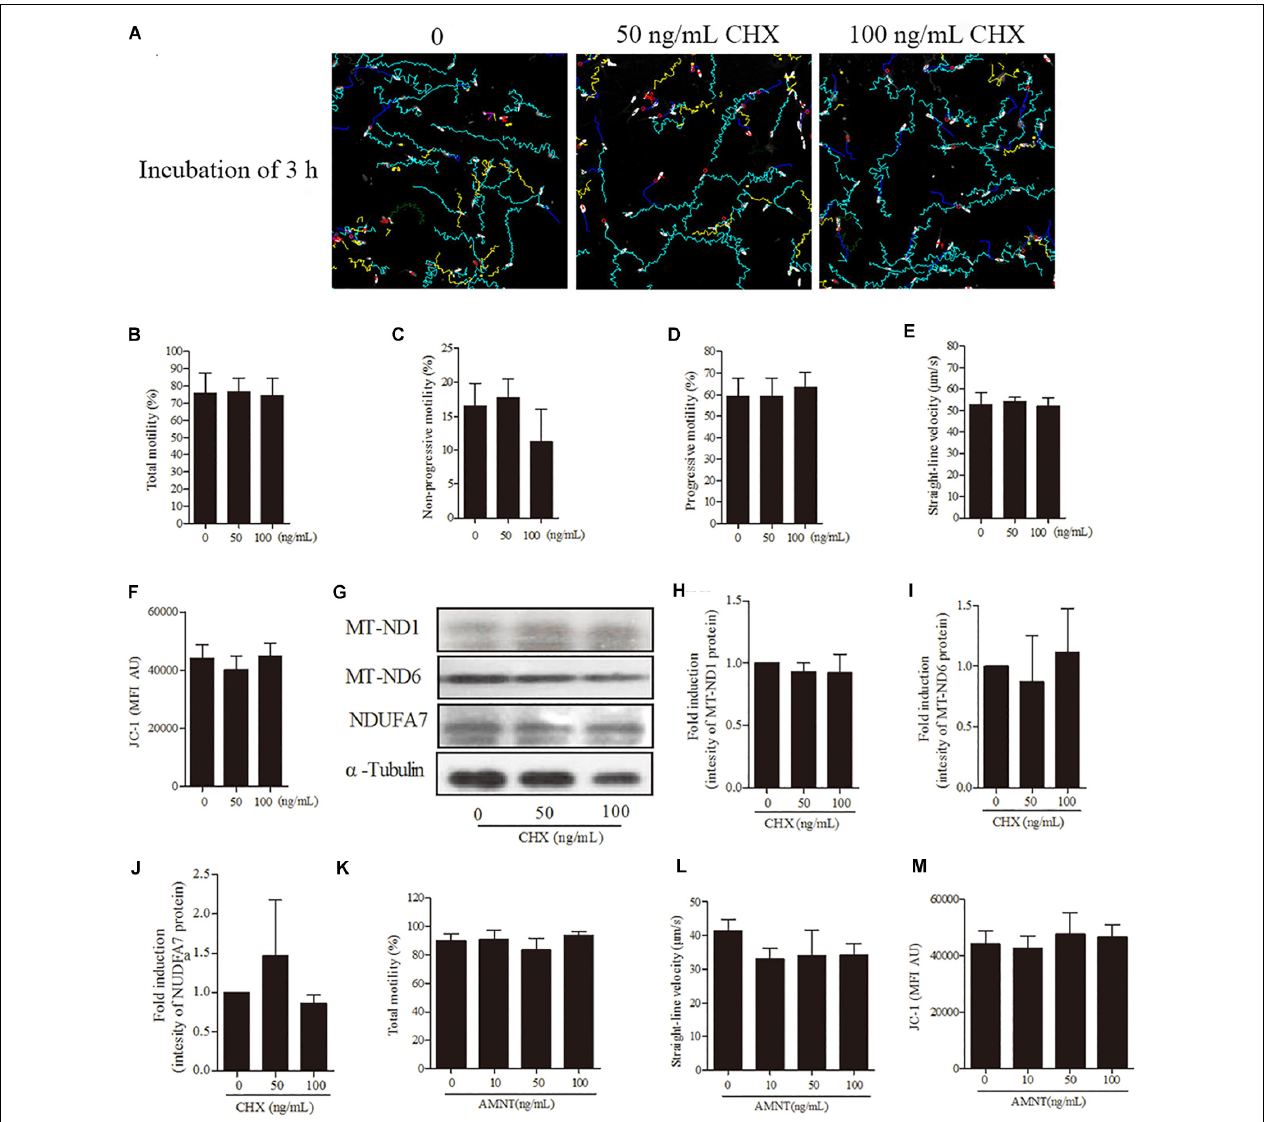
FIGURE 6 | Effects of cycloheximide (CHX) and α -amanitin (AMNT) on boar sperm at 3 h of incubation 30.6 mM glucose media. (A) Tracks of sperm motility incubated with different concentrations of CHX (0, 50, and 100 ng/mL) generated by CASA system. (B–E) Motility patterns: (B) total motility, (C) non-progressive motility, (D) progressive motility, (E) straight-line velocity. (F) Mitochondrial activity. (G) Western blotting image showing the expression of the MT-ND1, MT-ND6, NDUFA7, and α -tubulin. (H–J) Quantitative expression of the MT-ND1, MT-ND6, and NDUFA7 over α -tubulin (control) generated from western blotting. (K) Total motility, (L) straight-line velocity, and (M) mitochondrial activity of sperm were not changed after 3 h of incubation with different concentrations of AMNT (0, 10, 50, and 100 ng/mL). Values are means ± SE of three replicates. Columns with different lowercase letters differ significantly ( p <